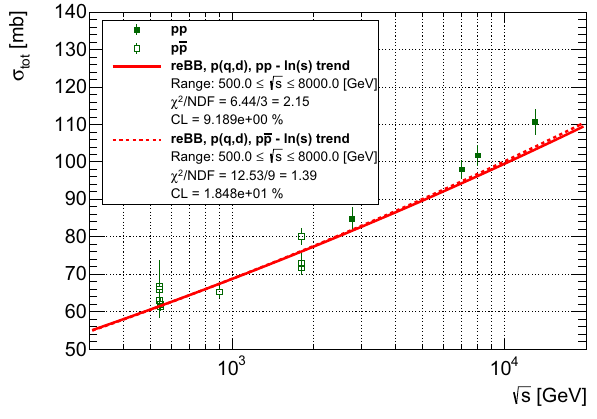
Fig. 14 Result of the sanity test for pp [6,65,68] and p ¯ p [50] total cross section data. It was calculated from the model when the values of the parameters R q , R d , R qd and α were taken from Eq. 10 and Table 2, corresponding to the linear curves shown on panels (a)–(d) of Fig.6